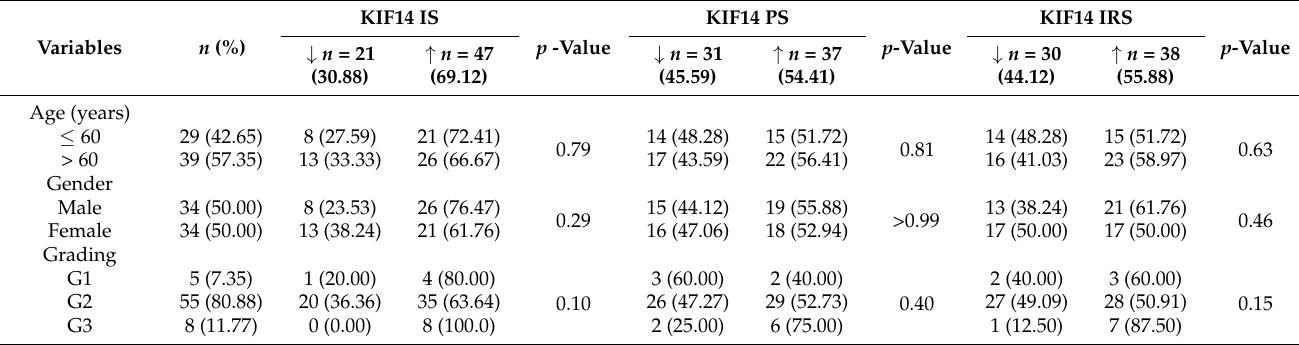
Table 2. Characteristics of the study population by KIF14 immunoexpression